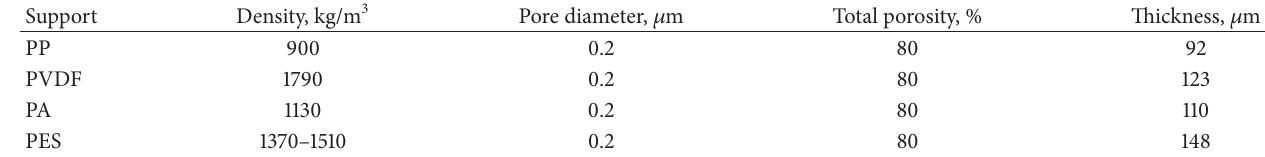
Table 2: Physicochemical parameters of polymeric supports reported by producer.